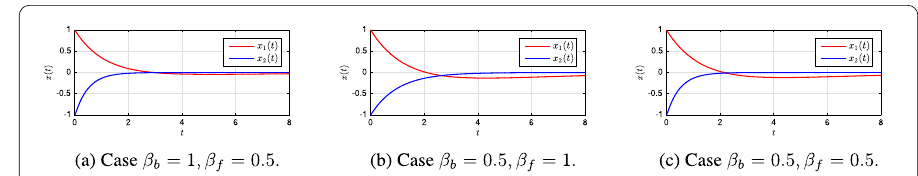
Figure 1 Trajectories of (DINAM) for different values of the parameters β b , β f